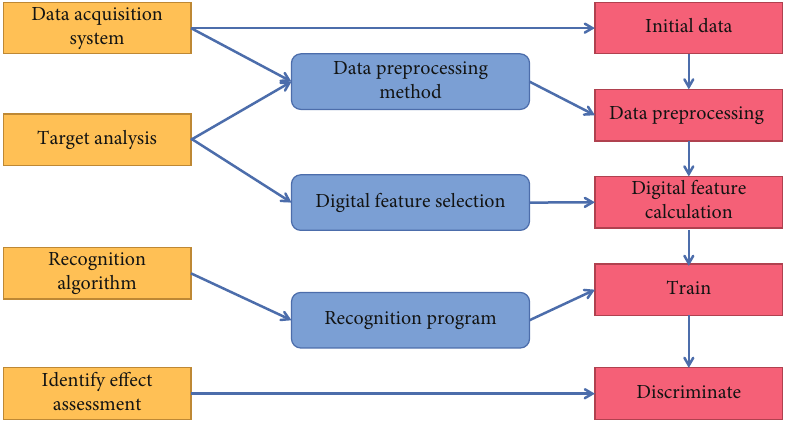
Figure 2: Action recognition process.